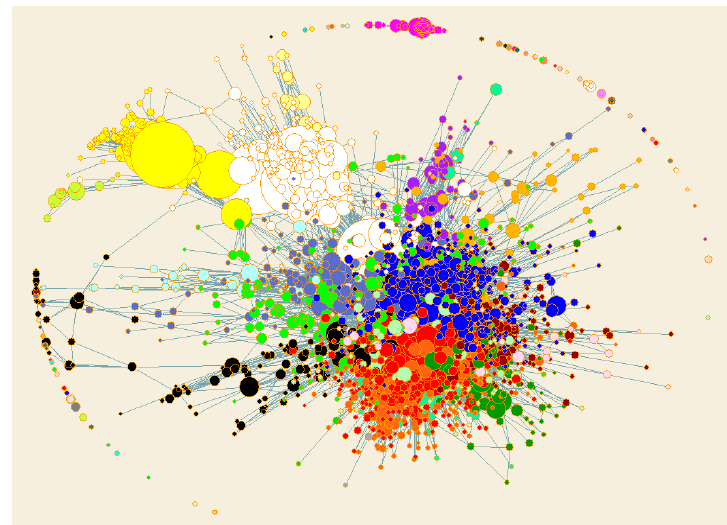
Figure 1. Communities in the construction market.